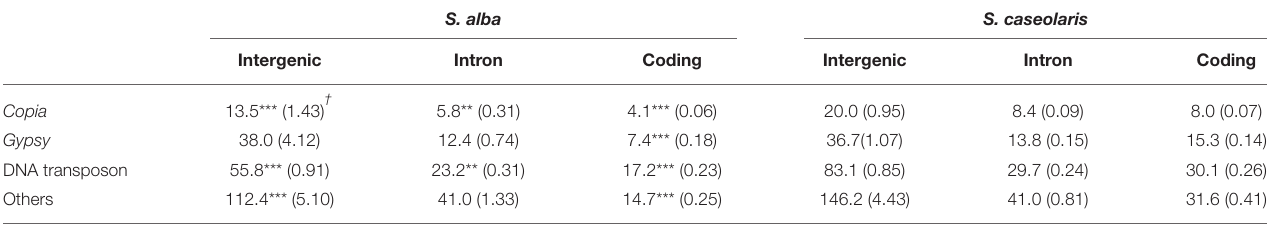
TABLE 1 | Location of TE insertions in relation to coding regions in S. alba and S. caseolaris .